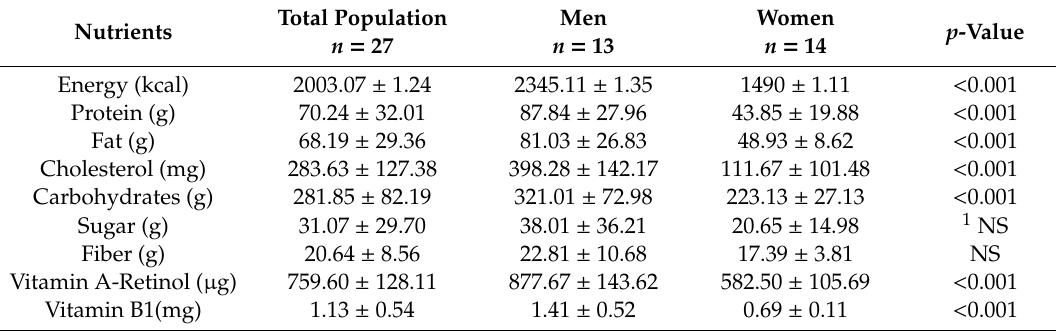
Table 4. Daily intake of energy and nutrients of all adolescents and by group (men and women) included in the supplementation